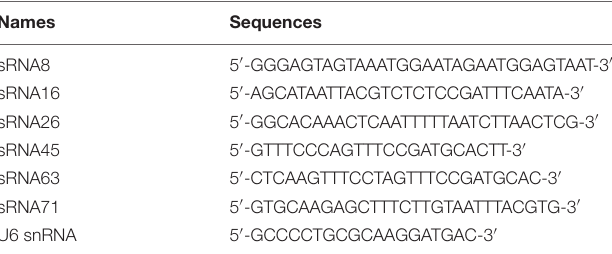
TABLE 3 | Primers used in